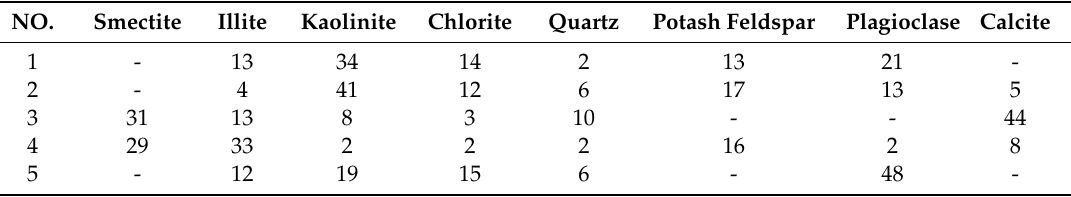
Figure 5. Surrounding rock cores and its micro-structures in an underground gold mine. ( a ) Surrounding rock cores: granulite cores obtained in site from underground stope surrounding rock mass, ( b ) The dense layered structure: dense layered structure observed by SEM which may cause layered motion failure, ( c ) Fine and large cracks: A lot of fine cracks and large fissures were observed by SEM which may cause fracture and expand to form slip surface, ( d ) Nature holes and pores: existing naturally in rock mass, and the volume of them will shrink during compression test, resulting in elastic deformation. Table 3. Main minerals of the rock core (RC) specimens (wt.